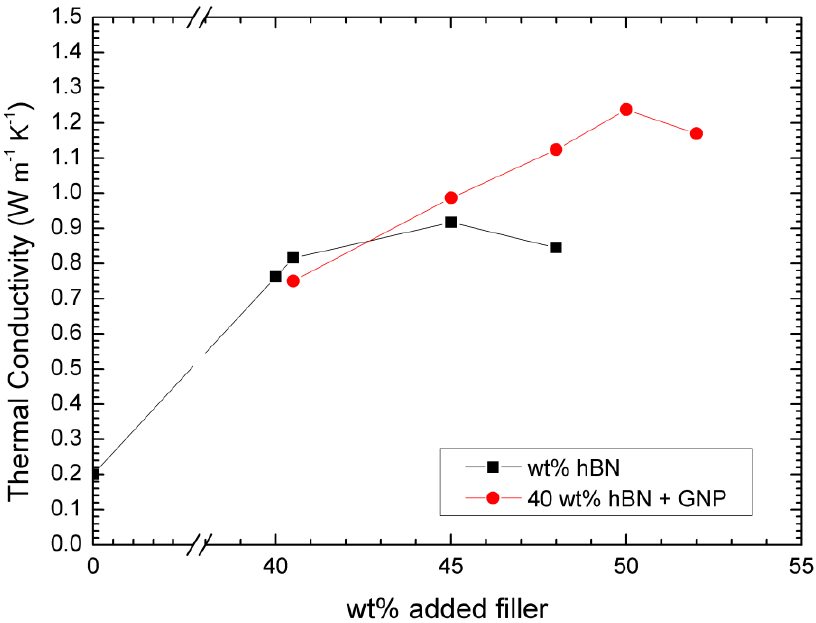
Figure 4. Effect of the amount of filler (hBN or hBN/GNP) contained in PDMS matrix on their TC values.